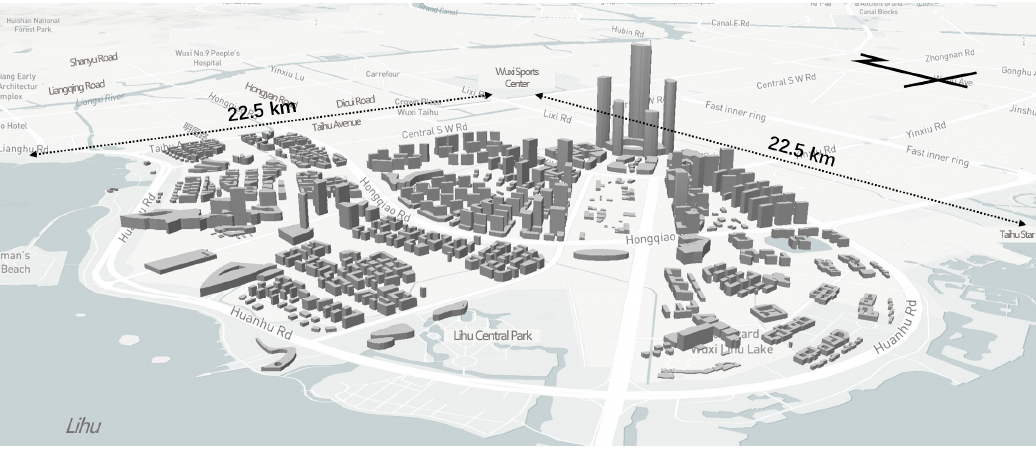
Figure 3. Aerial view of architectural scheme.